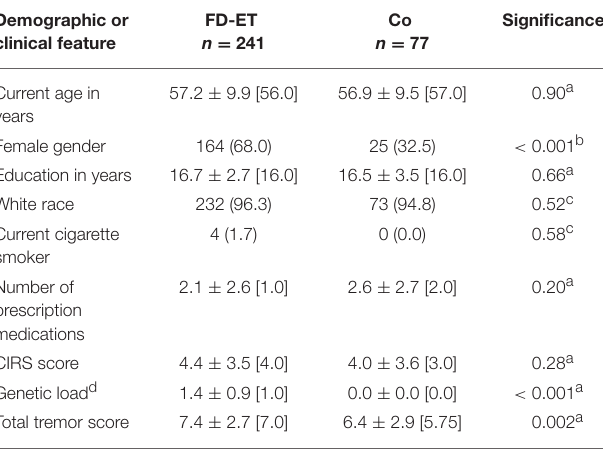
TABLE 1 | Demographic and clinical features of 241 FD-ET vs. 77 Co.